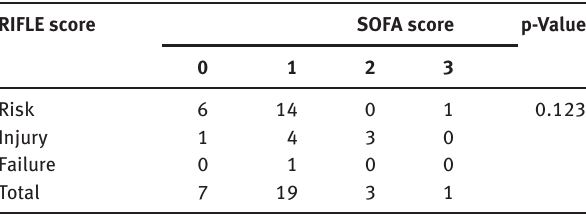
RIFLE, Risk, Injury, Failure, Loss, and End-stage; SOFA, Sequential Organ Failure Assessment; ICU, intensive care unit; AKI, acute kidney